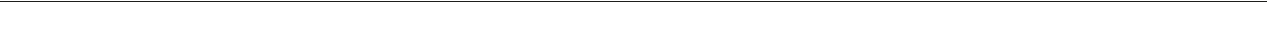
Fig. 5 Gene networks targeted by miR-130a & miR-145. a Identi fi cation of miRNA targeted genes from TargetScan mouse database, which was intersected with mRNA expression microarray data comparing tumor Gr-1 + CD11b + cells with those from healthy control mice. Seven targets were common for miR- 130a and -145. b IPA analysis of gene networks targeted by miR-130a (purple), miR-145 (blue), or both (orange) involving TGF β and IGF pathways. c Validation of the major pathway mediators comparing tumor-associated myeloid cells with those from healthy controls, qRT-PCR (left) and Western blot (right). d qRT-PCR (left) and Western blot (right) from Gr-1 + CD11b + cells ex vivo treated with miR-130a or -145 or control mimics. e Immuno fl uorescence images of T β RII (Green), IGF1R (red), and DAPI (blue) in Gr-1 + CD11b + cells from the spleen of 4T1 tumor-bearing mice. scale bar: 10 μ m. f M1/M2 cytokine ratio post restorations of T β RII, IGF1R, and IRS1 in Gr-1 + CD11b + cells that overexpress miR-130a or miR-145. The ratio of M1/M2 cytokines was calculated by dividing each M1 cytokine (TNF α , IL-12, GM-CSF) to M2 cytokine (IL-10, IL-4) as described in Material and Methods. g – l metastasis reduction by IGF1R inhibitor NT157: g The number of metastatic nodules of 4T1 tumor-bearing Tgfbr2 MyeKO and WT mice treated with NT157 ( n = 7 – 10). h The number of metastatic nodules in 4T1 tumor-bearing mice that received IGF1R inhibitor NT157. i qRT-PCR of ARG1, TGF β 1, and IL-10 in Gr-1 + CD11b + cells from 4T1 tumor-bearing mice treated with NT157 ( n = 5). j The number of metastatic nodules from mice bearing E0771 tumor treated with NT157 ( n = 5 – 6). k qRT-PCR of ARG1, TGF β 1, and IL-10 in Gr-1 + CD11b + cells from E0771 tumor-bearing mice treated with NT157 ( n = 4). l The number of metastatic nodules of 4T1 tumor-bearing mice treated with NT157 with CD8 α neutralizing antibody or IgG as control ( n = 10). Mice with similar tumor weight were used for metastatic nodule counts (Supplementary Fig. 5j). Data are presented as mean±SEM, and Student ’ s t test was